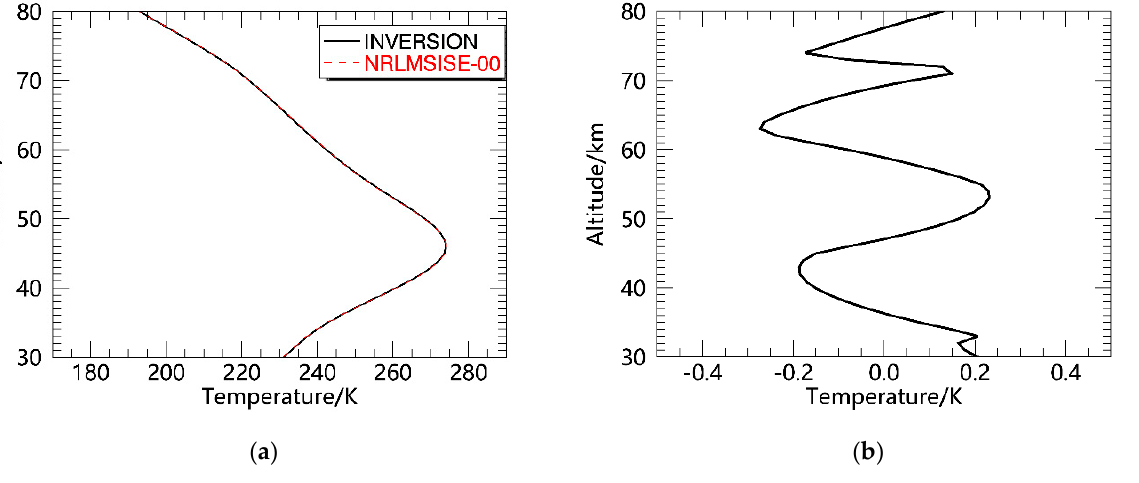
Figure 6. (a) Comparison of temperature between the inversion and NRLMSISE-00 model from 30 km to 80 km without rolling; (b) deviation in temperature between the inversion and NRLMSISE- to 80 km without rolling; ( b ) deviation in temperature between the inversion and NRLMSISE-00 00 model from 30 km to 80 km without rolling. model from 30 km to 80 km without